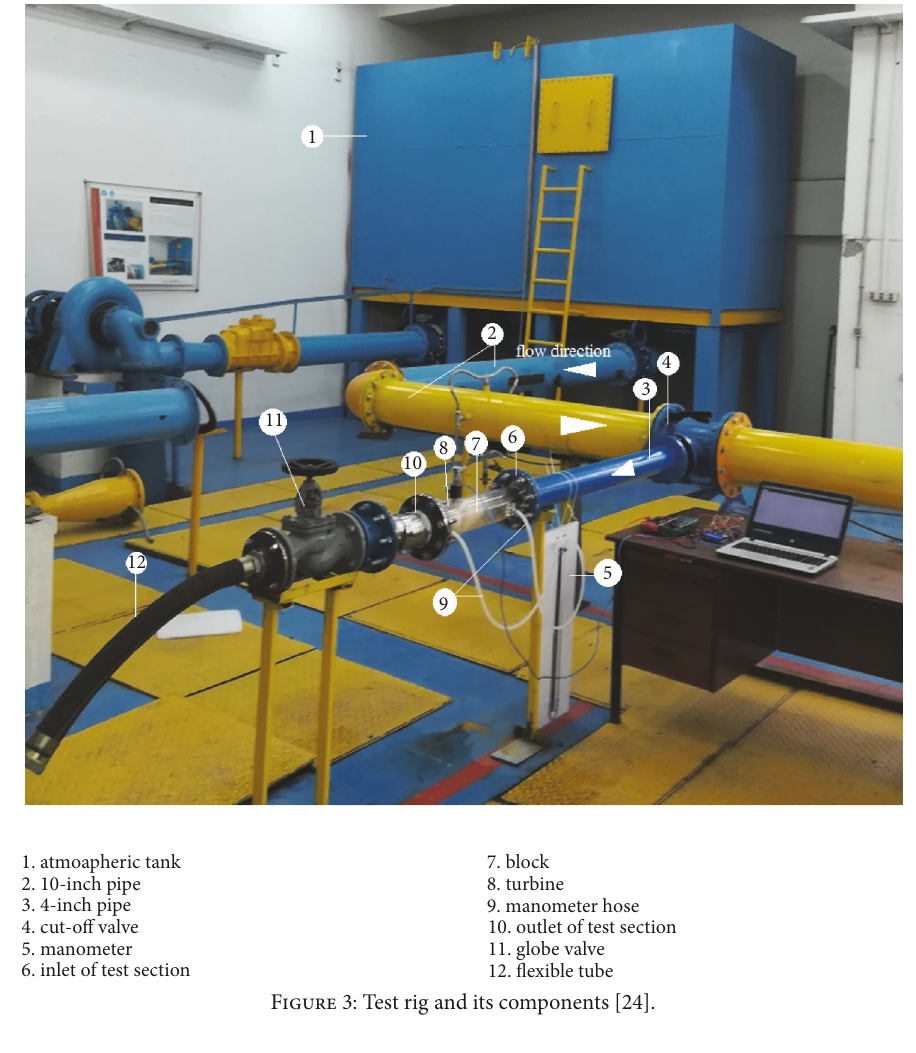
Figure 3: Test rig and its components [24].